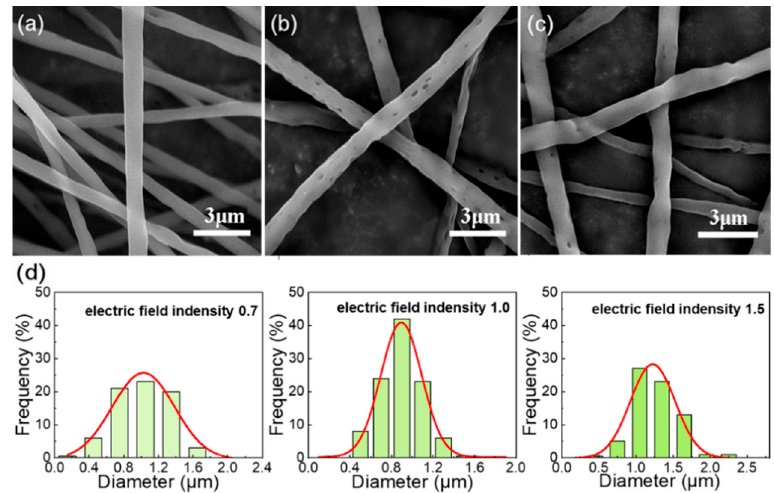
Figure 5. SEM images of the electrospun fibrous membrane with 17% solution concentration at different curing distance, ( a ) 22 cm; ( b ) 16 cm; ( c ) 11 cm; ( d ) Gaussian fitting curve of fiber diameter distribution prepared under different curing distances.